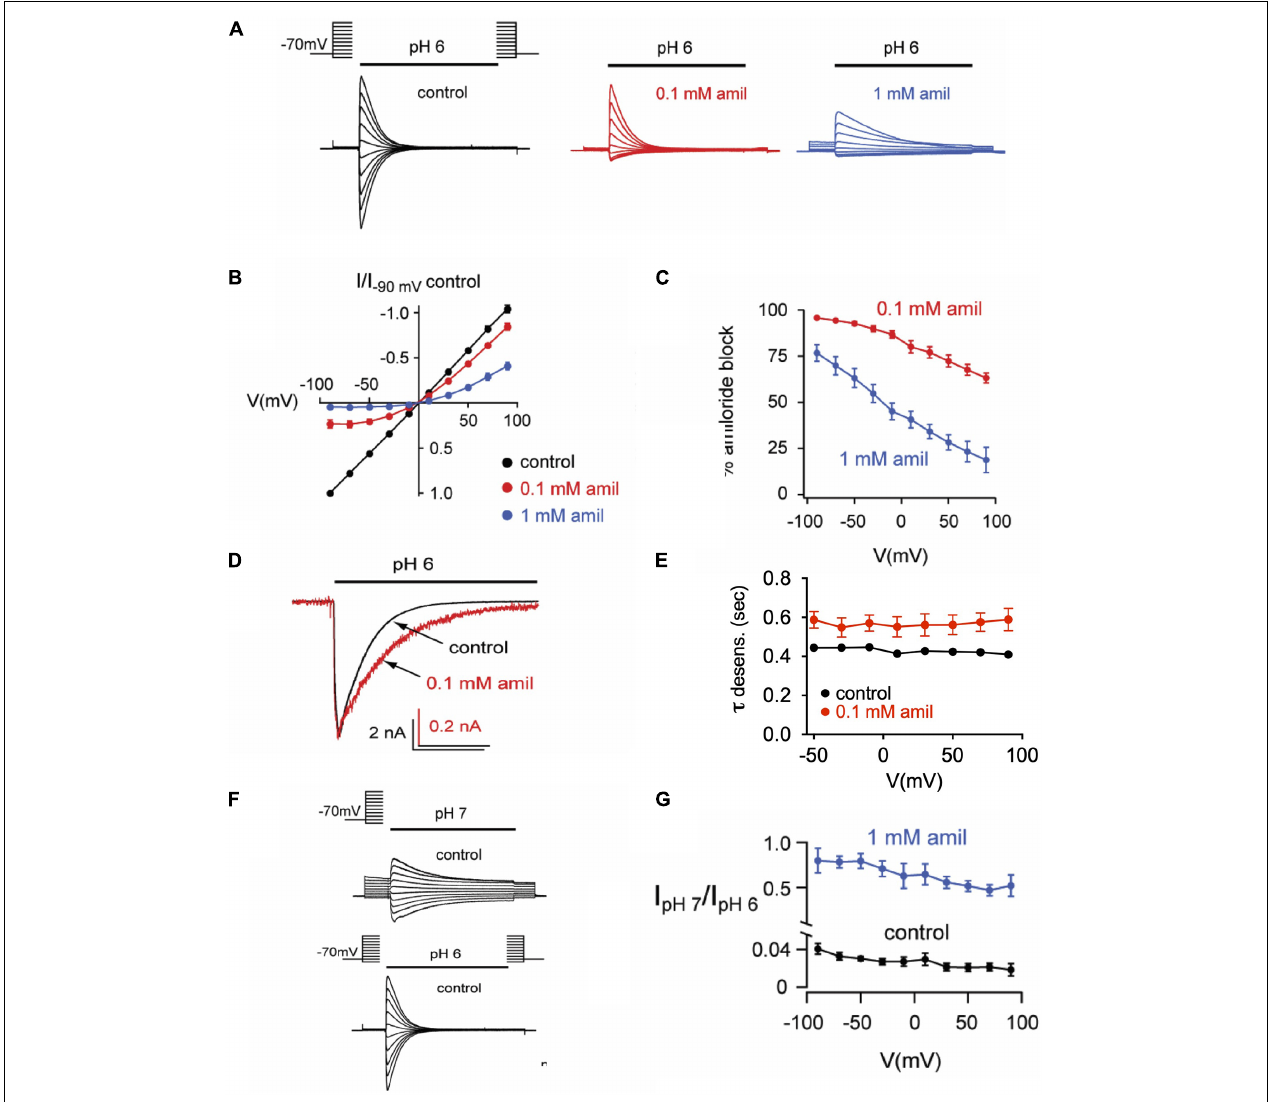
FIGURE 7 | Effects of amiloride on ASIC3 are voltage-dependent and voltage-independent. (A) Overlays of pH 6-evoked ASIC3 currents recorded during steps to various membrane potentials ( − 90 to + 90 mV). The test solution (pH 6) contained 0 (control), 0.1, or 1 mM amiloride. The intracellular (pipette) and extracellular solutions contained symmetrical NaCl concentrations. (B) Current vs. voltage curves for the data in A . Data are normalized to the currents evoked at -90 mV in no amiloride ( n = 17) vs. 0.1 mM ( n = 7) and 1 mM ( n = 10) amiloride. (C) Mean percentage of pH 6-evoked current block by 0.1 mM ( n = 10) and 1 mM ( n = 6) amiloride at the indicated voltages. (D) Overlays of pH 6-evoked normalized currents in the absence (control) or presence of 0.1 mM amiloride. (E) Mean time constants of desensitization ( τ ) recorded in 0 ( n = 21) or 0.1 mM (n = 7) amiloride at the indicated voltages. (F) Overlays of pH 7- and pH 6-evoked currents recorded during steps to various membrane potentials ( − 90 to + 90 mV ). (G) Mean ratios of pH 7- to pH 6-evoked current amplitudes recorded in test solutions containing 0 mM ( n = 3) or 1 mM ( n = 3) amiloride at the indicated